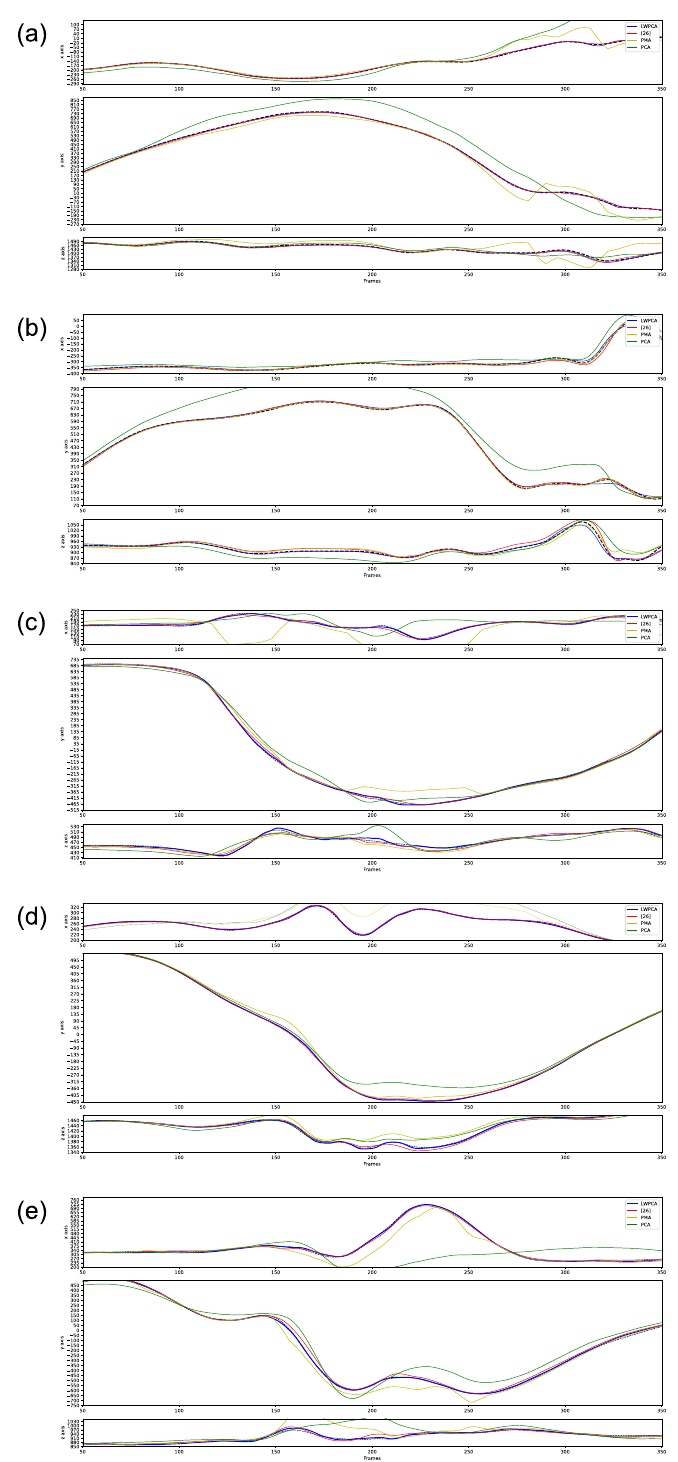
Fig 2. Comparison of the reconstruction for single missing gap at joints-9,14 on HDM data and joints-21,30,33 on CMU data respectively. Dotted lines represent the ground truth trajectories of joints. As WPCA is very close to LWPCA, it is not shown